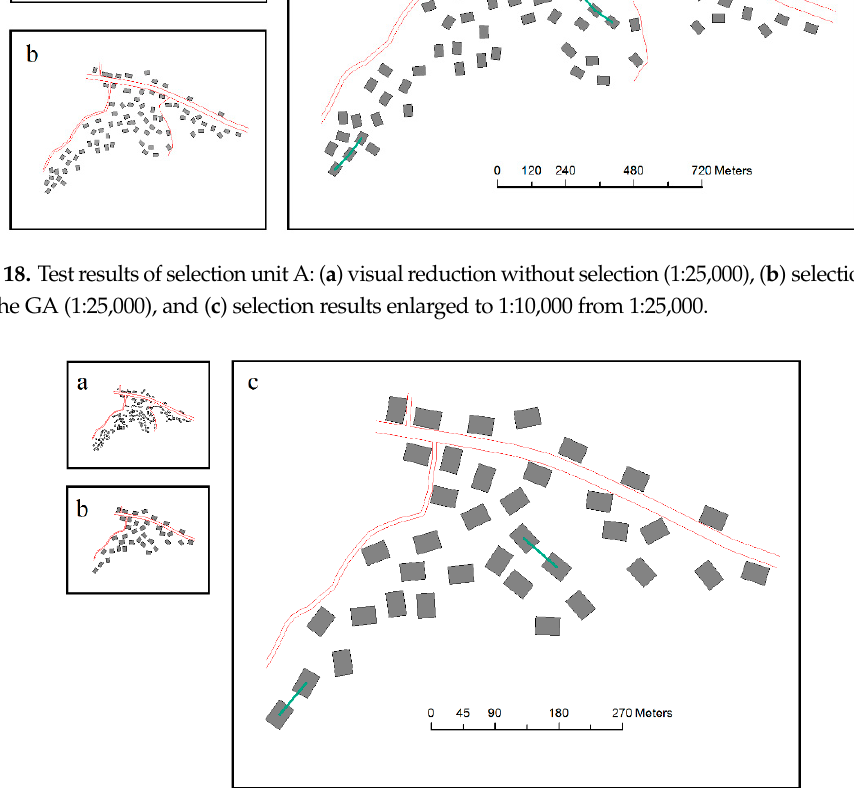
Figure 19. Test results of selection unit A: ( a ) visual reduction without selection (1:50,000), ( b ) selection result using the GA (1:50,000), and ( c ) selection result enlarged to 1:10,000 from 1:50,000.